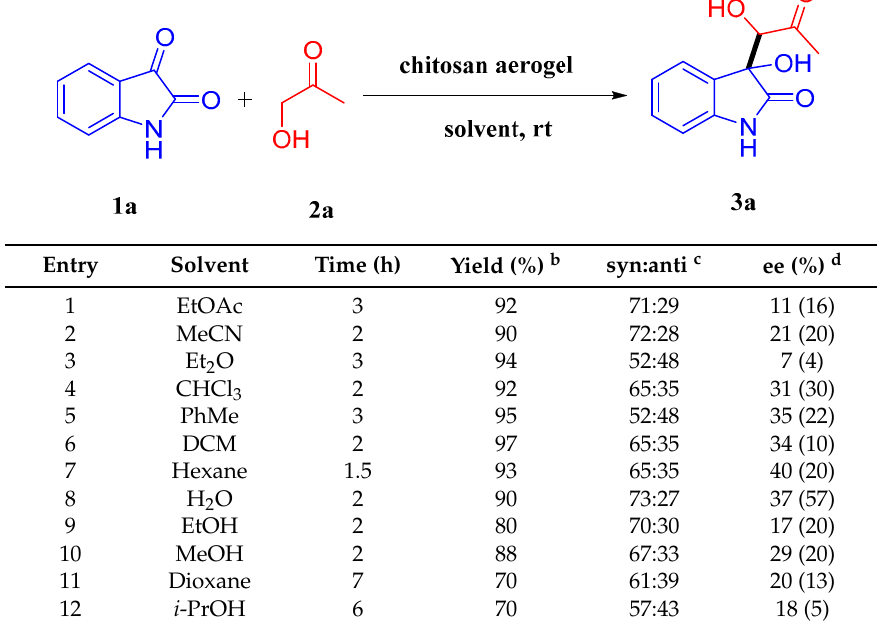
Table 1. Screening of the solvents for the enantioselective aldol reaction of isatin and hydroxyacetone catalyzed by chitosan aerogel a .